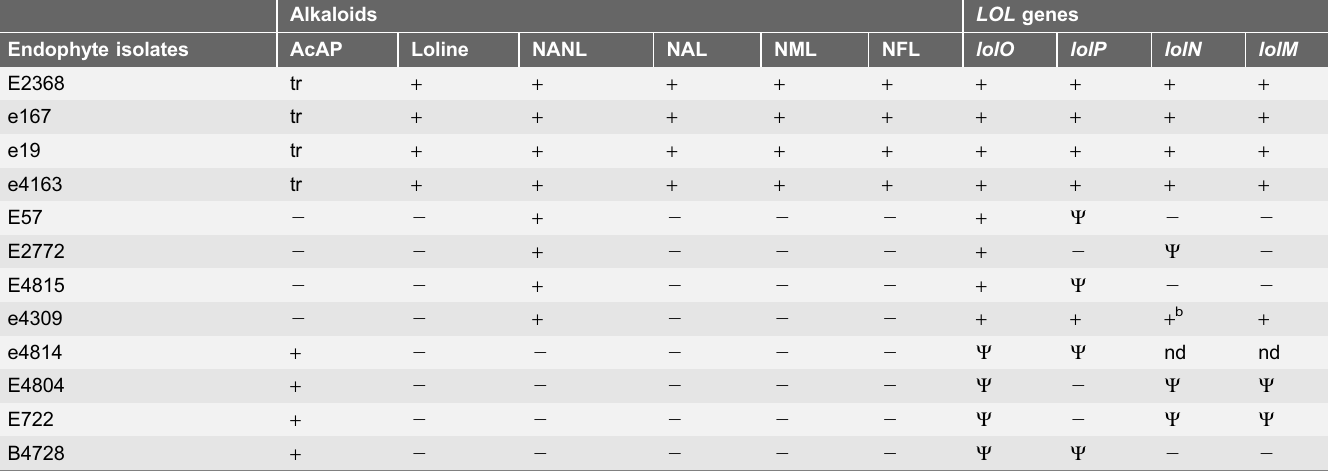
Table 2. Loline alkaloid profiles and LOL- gene screening results for endophyte isolates. a